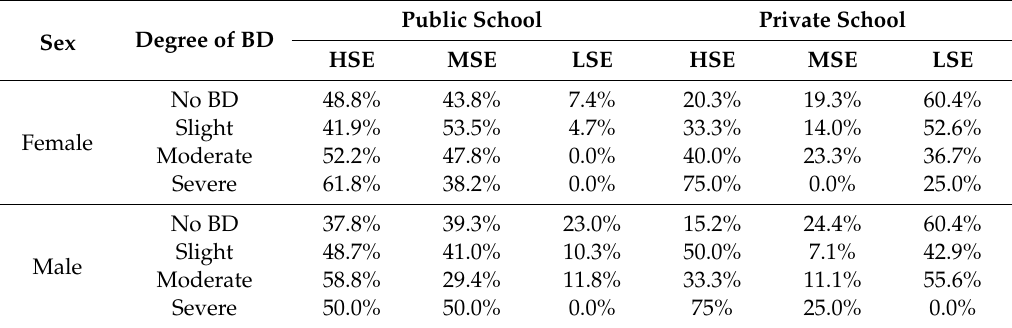
Table 2. Level of self-esteem by degree of body satisfaction, sex and school type, expressed in percentages.